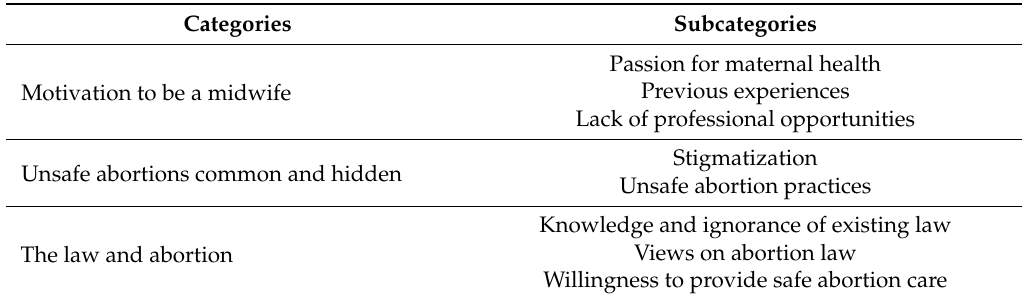
Table 1. Categories and subcategories from participants’